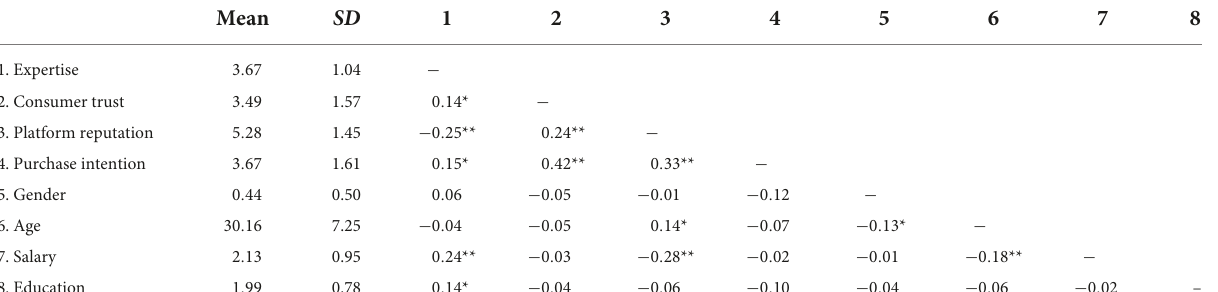
TABLE 1 Descriptive statistics and